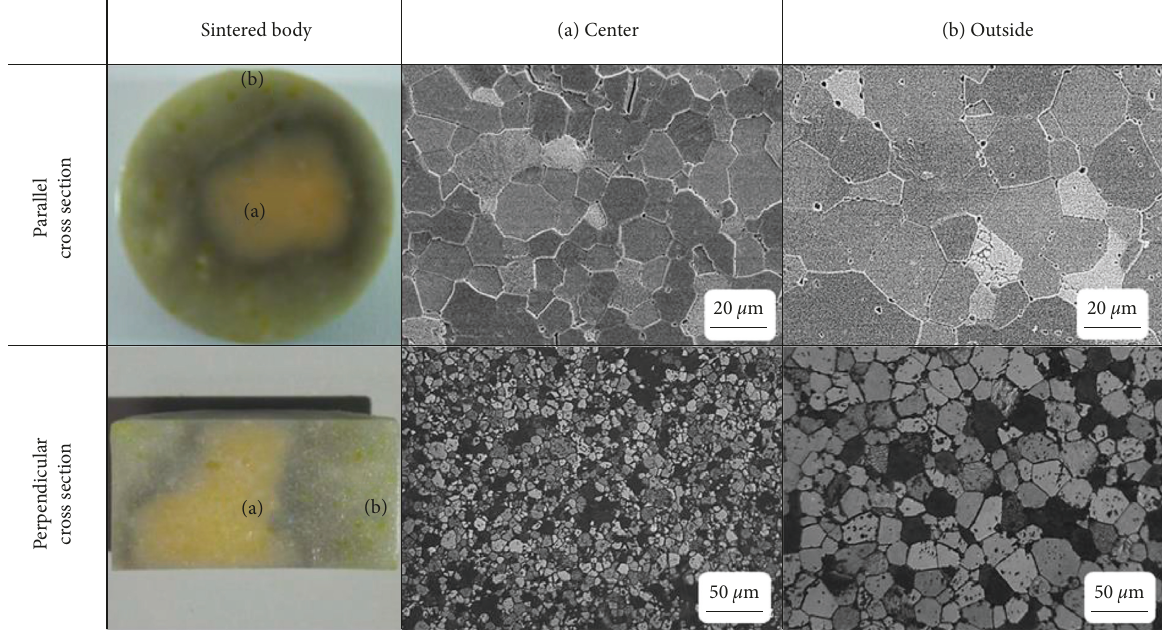
Figure 4: Perpendicular and parallel cross-sectional microstructures of the ZnO ceramics compacted by uniaxial pressing and CIP and sintered at 1300 ° C for 2 h recorded from (a) central region and (b) outer region.